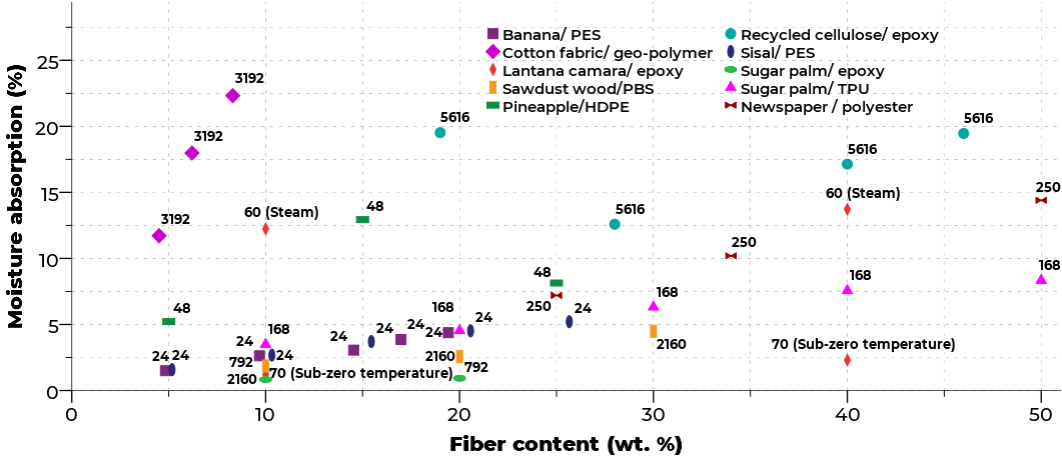
Figure 9. The effect of fiber loading and immersion time (shown in the above data points) on the percentage of moisture absorbed by natural composites. Banana fiber/polyester [74], CF/geopolymer [28], Lantana camara fiber/epoxy [68], Padauk sawdust wood/ biodegradable PBS [157], Pineapple fiber/HDPE [155], RCF/epoxy [154], Sisal/PES [232] , SPF/epoxy [76], SPF/TPU [158], Unshredded waste newspaper/PES [233] .